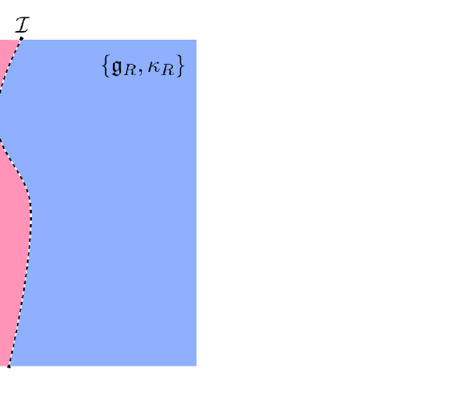
Figure 1 . On the left two Chern-Simons theories joined on an interface. Alternatively, once folded, this is a theory valued in the tensor sum with a hard